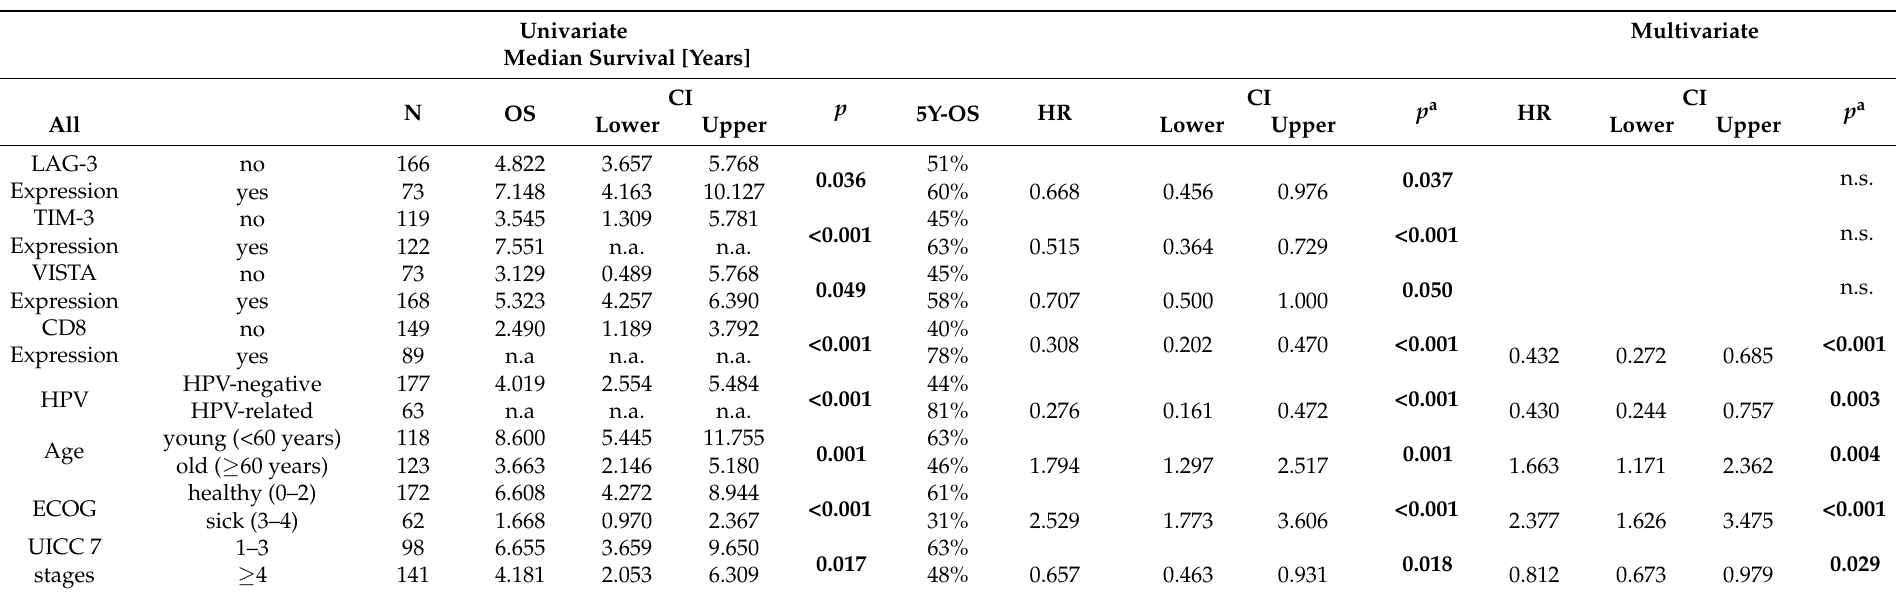
Table 3. Univariate and multivariate survival analysis according to risk factors and tumor characteristics in the whole cohort ( n = 241). Univariate